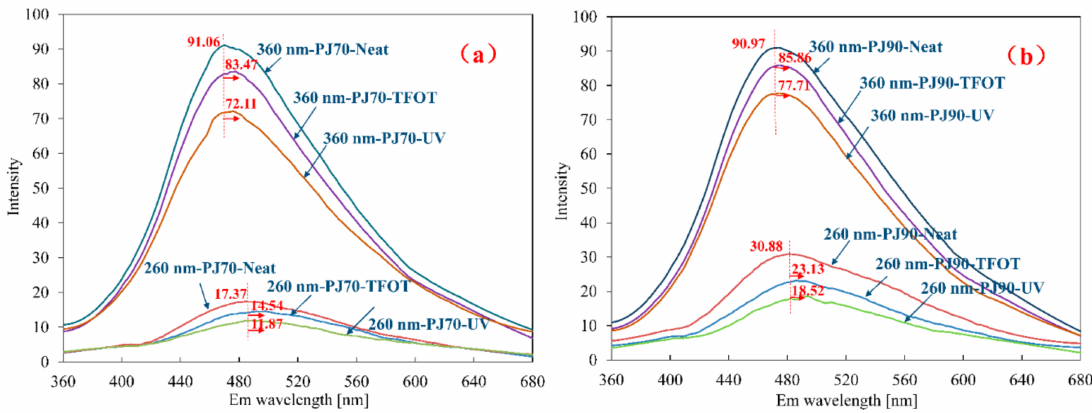
Figure 4. Emission spectrum of bitumen: ( a ) PJ-70 and ( b )